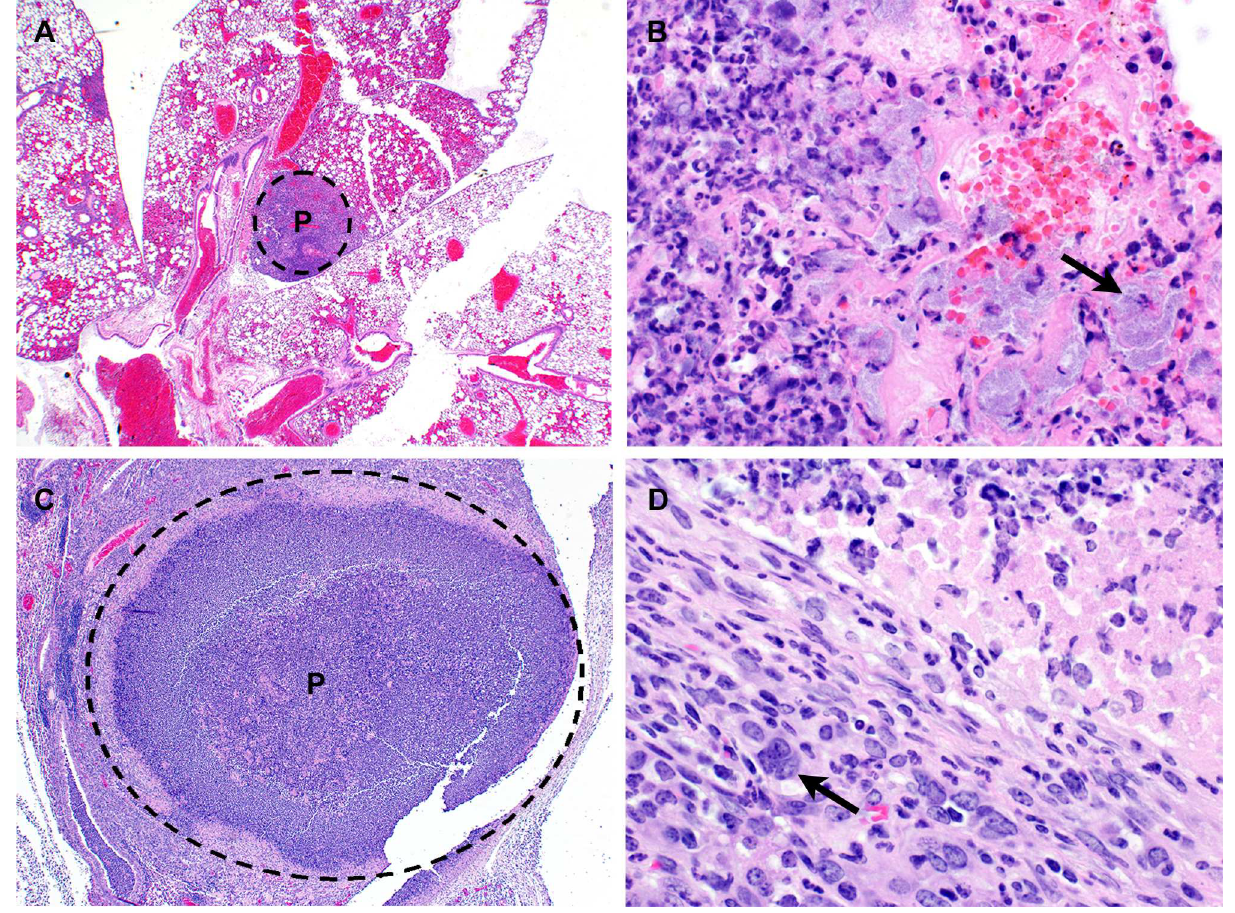
Fig 10. Lung histopathology observed in mice following exposure to aerosolized B . pseudomallei K96243.(A) C57BL/6mouse euthanized on day 2 post-infection. Lung: Multifocalrandom (embolic) suppurative pneumonia. H&E 20X. (B) BALB/c mouse euthanizedon day 4 post-infection. Lung: Suppurative inflammation and alveolarnecrosis with numerousshort bacilli(arrow). P = pyogranuloma; H&E 600X. (C) BALB/c mouse euthanized on day 7 post-infection. Lung: Focally extensive pyogranuloma. P = pyogranuloma; H&E 40X. (D) Lung: Peripheryof pyogranuloma with MNGC macrophage (arrow) formation. H&E